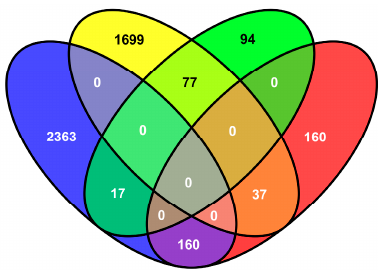
Figure 5. Venn diagram of differential gene expression. Blue and yellow ovals represent upregulated and downregulated differentially expressed genes (DEGs) in the resistant genotype, respectively. Green and red ovals represent upregulated and downregulated DEGs in the susceptible genotype, respectively.